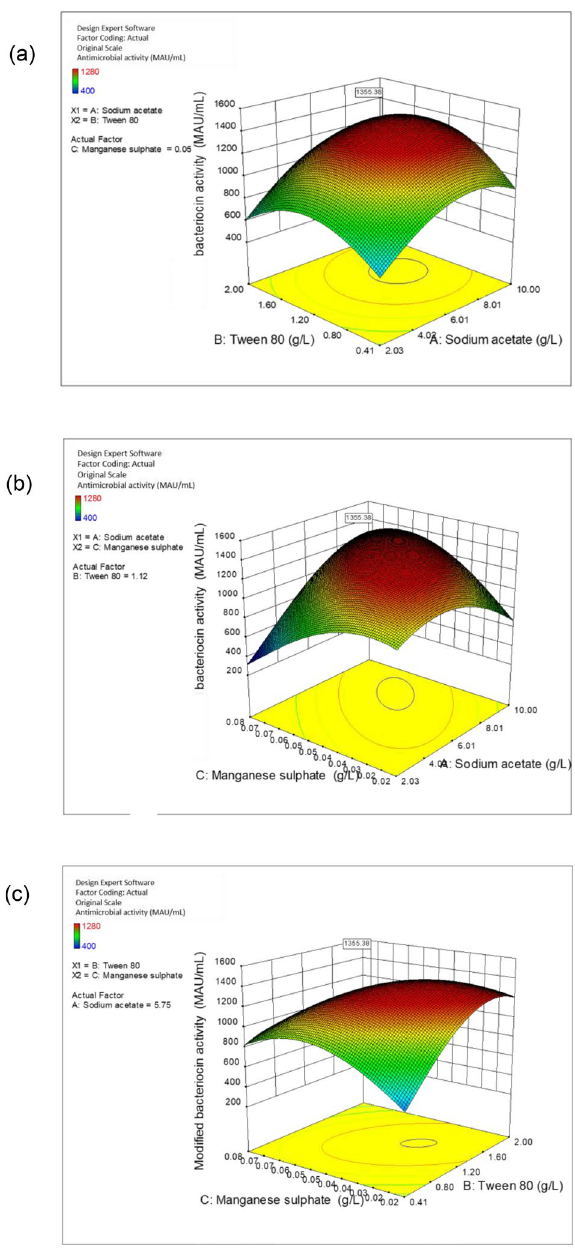
Tween 80 and manganese sulphate